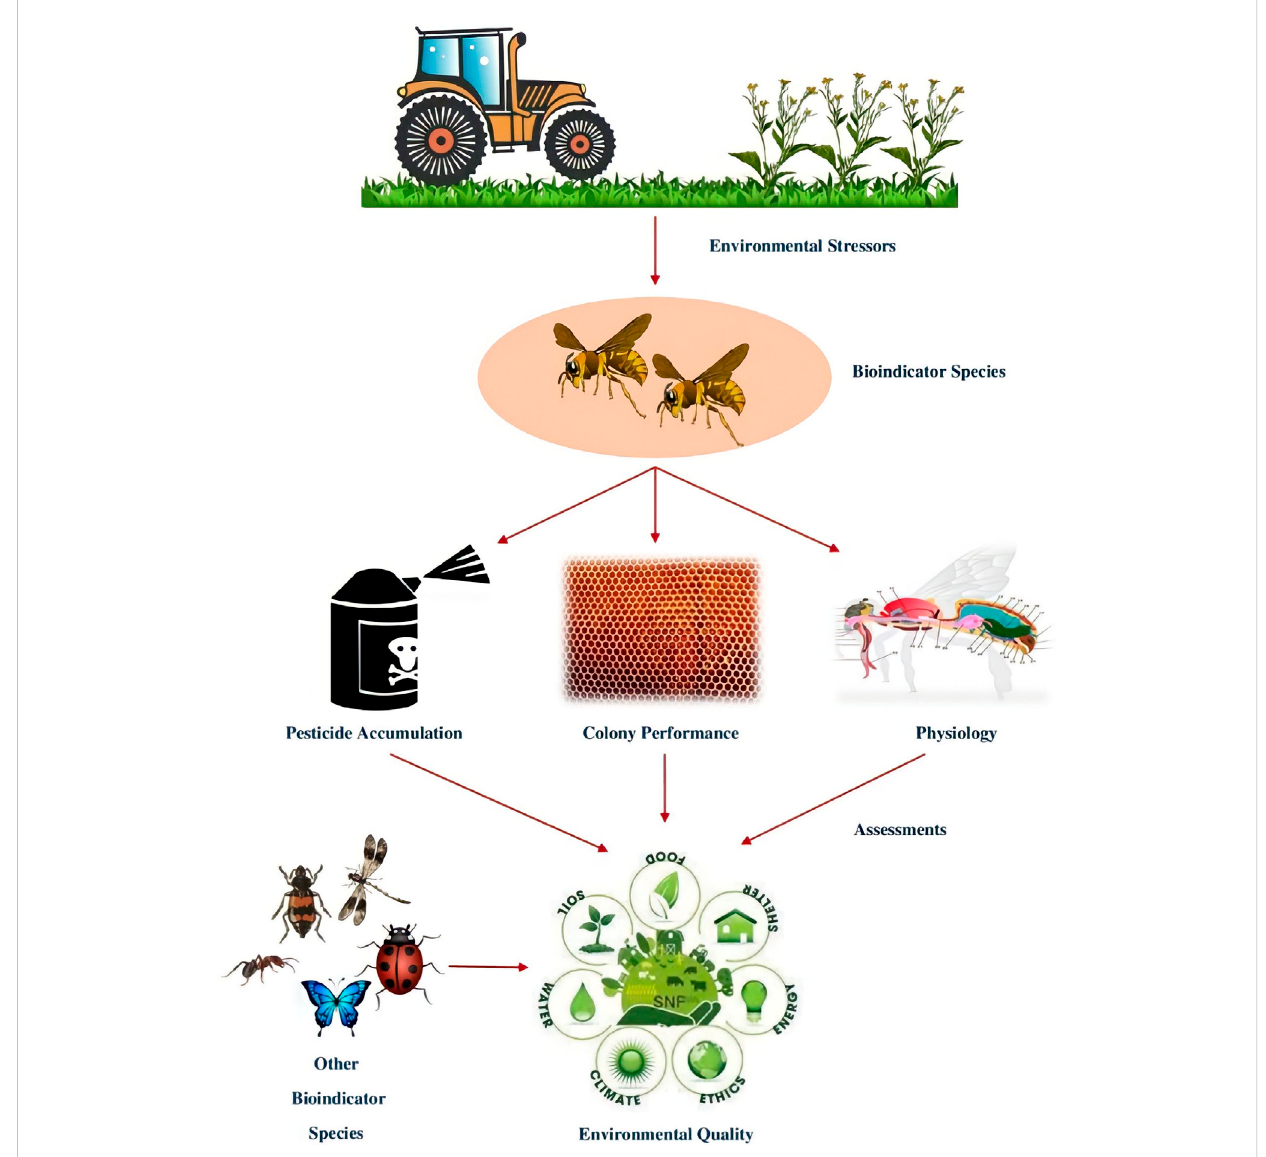
FIGURE 3 Schematic fl ow diagram of climate change indication by honey bee and other